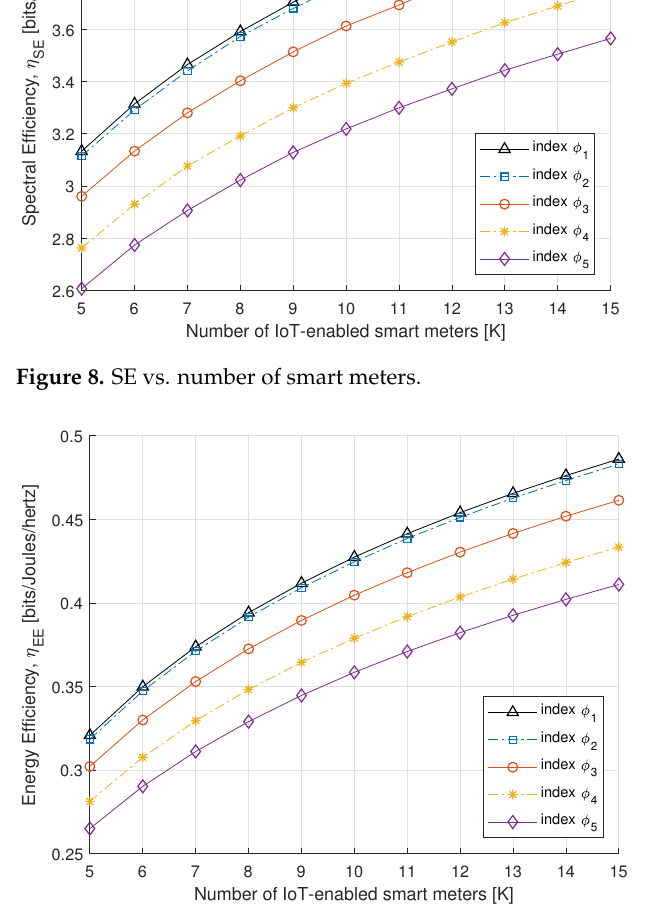
Figure 9. EE vs. number of smart